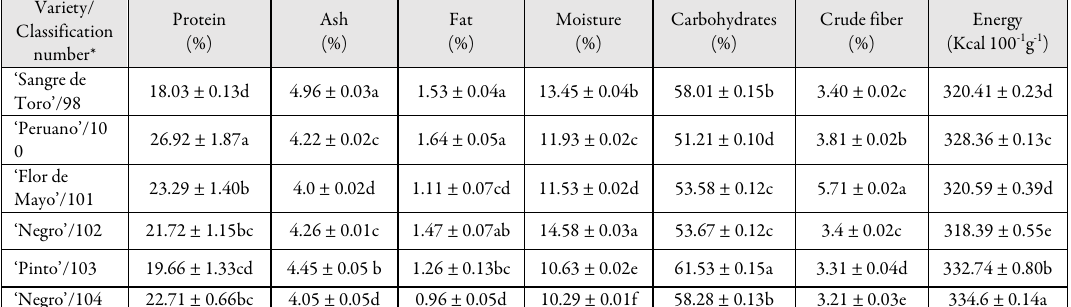
Table 4. Nutritional composition of several common bean varieties from Morelos State, Mexico Variety/